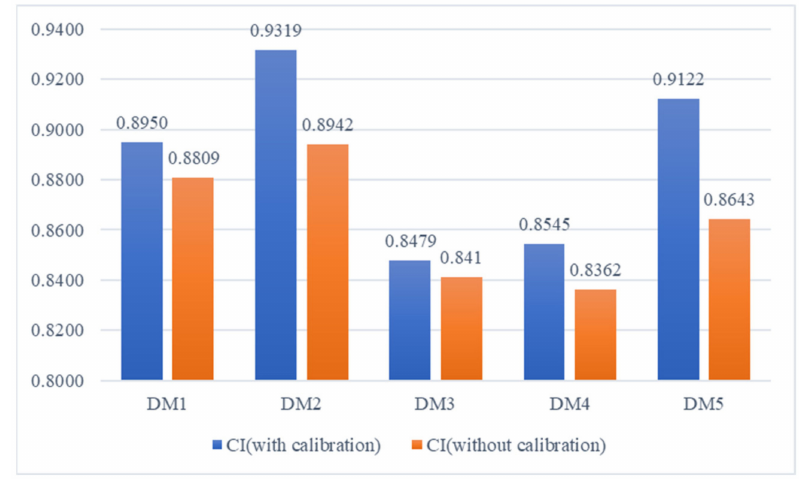
Figure 9. The CI of DMs under different linguistic models.